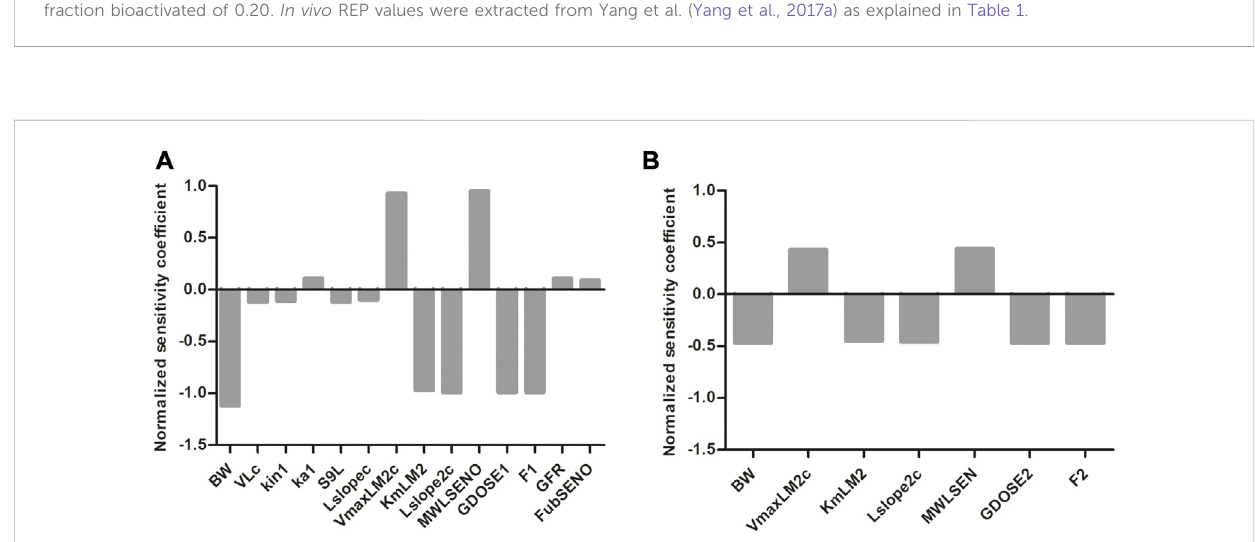
FIGURE 8 Normalized SCs for the parameters of the rat PBK model for (A) SENO and (B) SEN dosage on predicted amount pyrrole-proteinadducts (µmol) at equimolar doses of 55 μ mol kg -1 bw. The in vitro k cat of 7-GS-DHP formation is 0.0023 or 0.00145 mL min -1 mg -1 S9 for oral SENO or SEN, respectively. The complete list of abbreviations can be found in Table 1S of the Supplementary